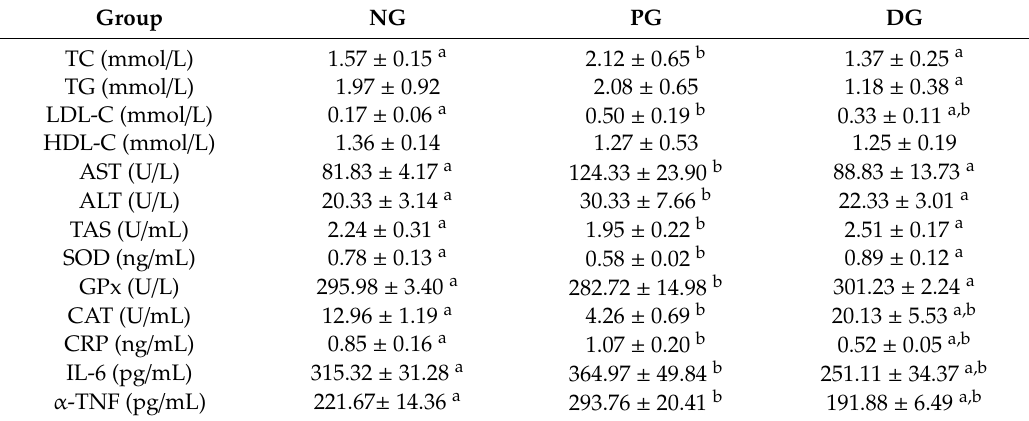
Table 4. The beneficial e ff ects of DDP treatment diet on hypercholesterolemic